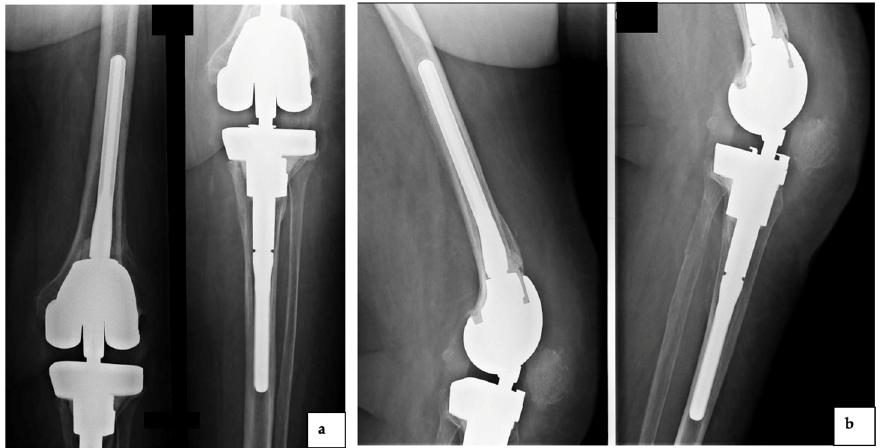
Figure 2. The plain radiograph showed periprosthetic infection of the rotating hinge knee implant due to Abiotrophia defectiva (( a ): anteroposterior view and ( b ): lateral view).